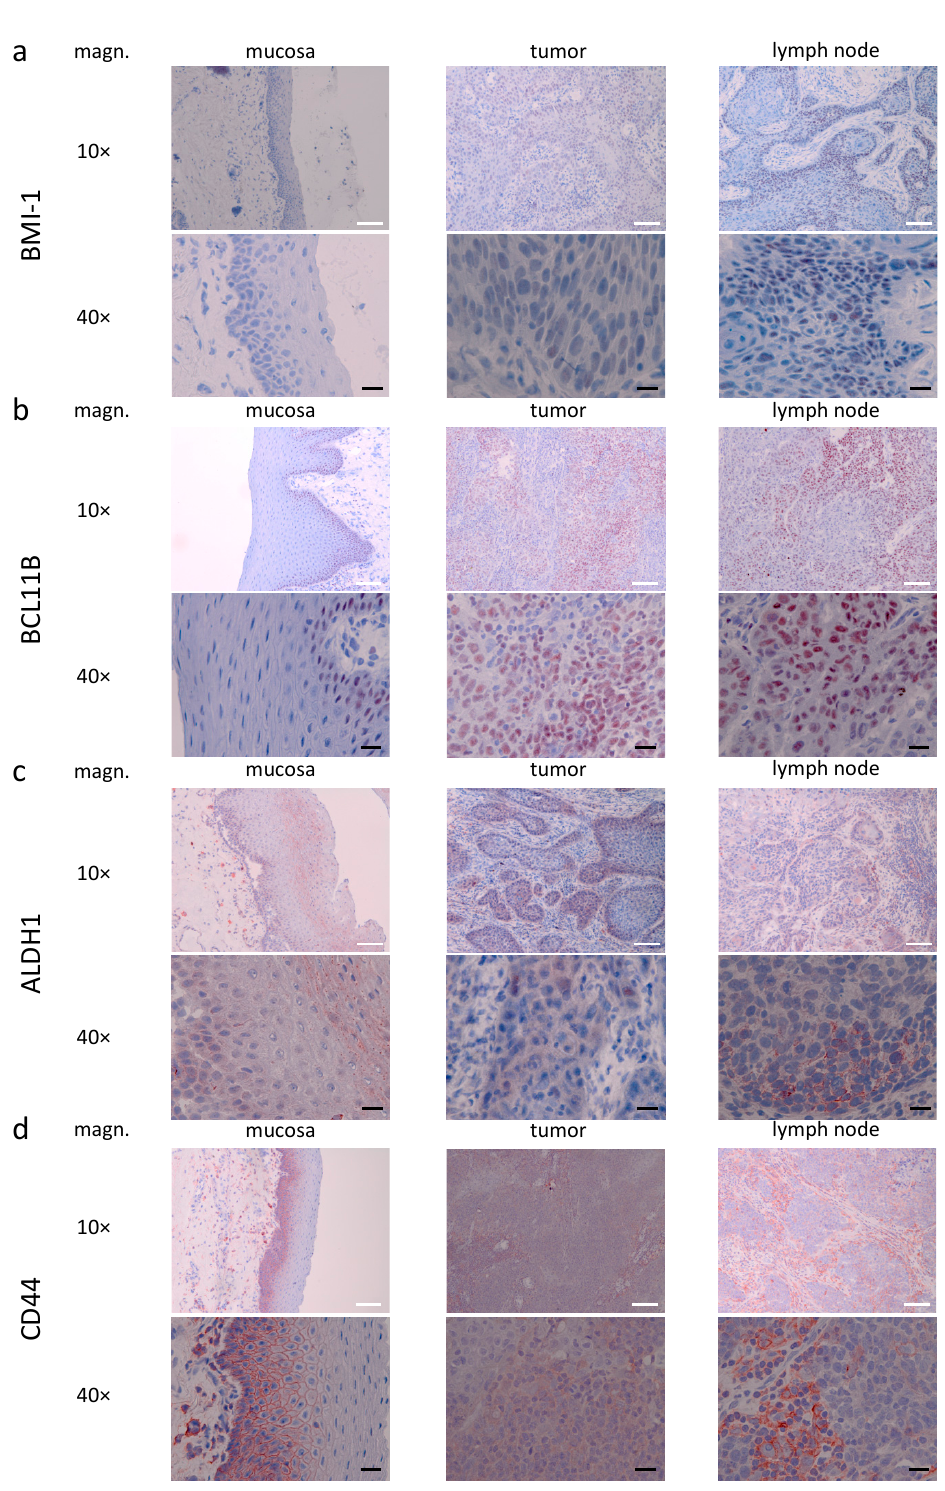
Figure 3. Expression patterns of CSC markers ALDH1, BCL11B, BMI-1, and CD44 in the primary tumor, lymph node metastasis, and healthy mucosa. Shown are representative examples of BMI-1 ( a ), BCL11B ( b ), ALDH1 ( c ), and CD44 ( d ) expression (10× and 40× magnification) in HNSCC. The white bar in 10× magnification equals 100 µm, the black bar in 40× magnification equals 20 µm. Samples from the cohort with median IHC scores regardless of HPV status were chosen. ALDH1, BCL11B, BMI-1, and CD44 staining is red-brown, nuclei and cytoplasm are counter-stained with hemalaun (blue).